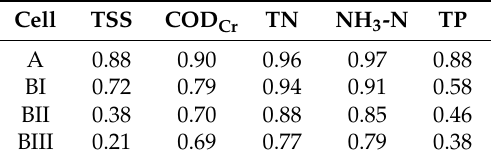
Table 4. Correlation coefficient between effluent and initial influent concentrations. Cell TSS COD Cr TN NH 3